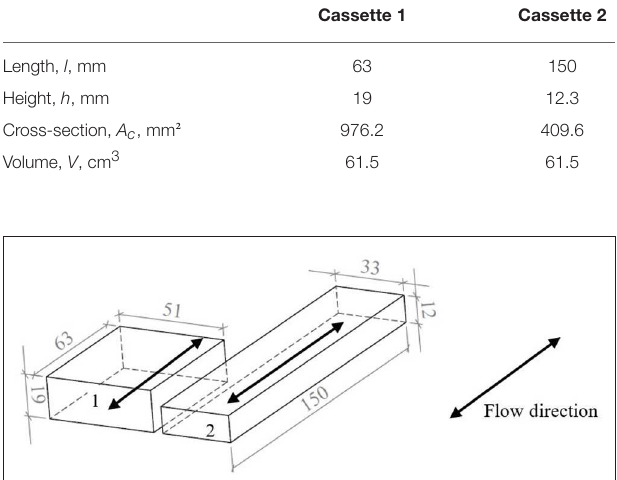
FIGURE 1 | Sketch of the modeled AMR beds. 1—cassette of the MagQueen , 2—cassette of the magnetocaloric prototype at KTH Royal Institute of Technology, Stockholm,